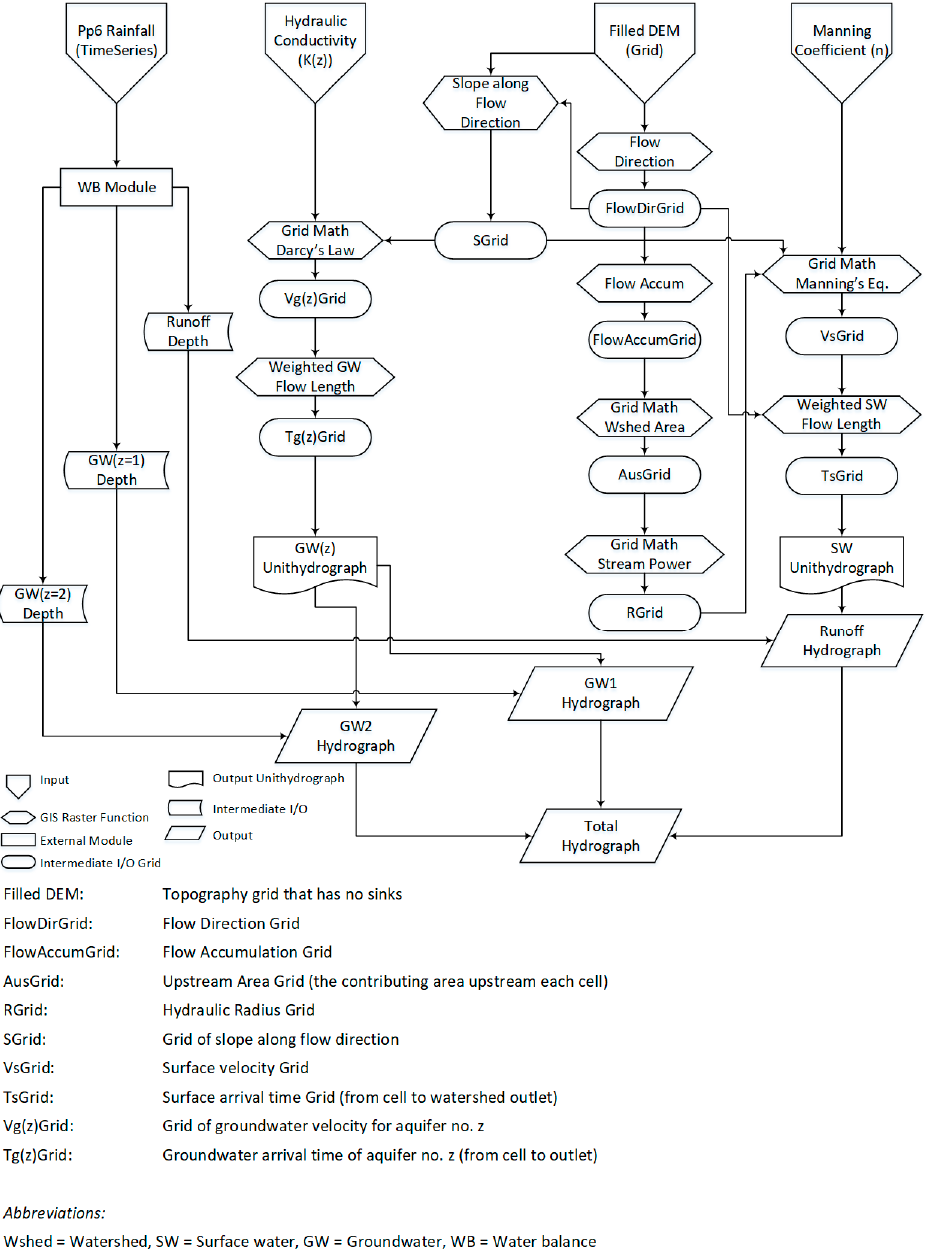
ff erent modules in SCHydro